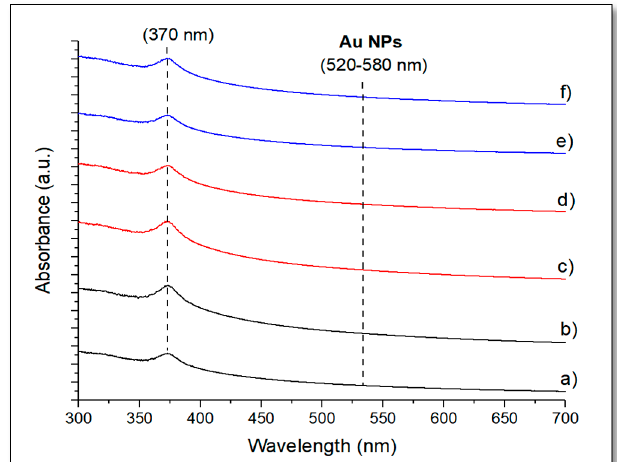
Figure 3. Raman spectra of 5%Au@commercial ZnO–graphene ( a ); 10%Au@commercial ZnO–graphene ( b ); 5%Au@ZnO NPs–graphene ( c ); 10%Au@ZnO NPs–graphene ( d ); 5%Au@ZnO NWs–graphene ( e ); and 10%Au@ZnO NWs–graphene ( f ).